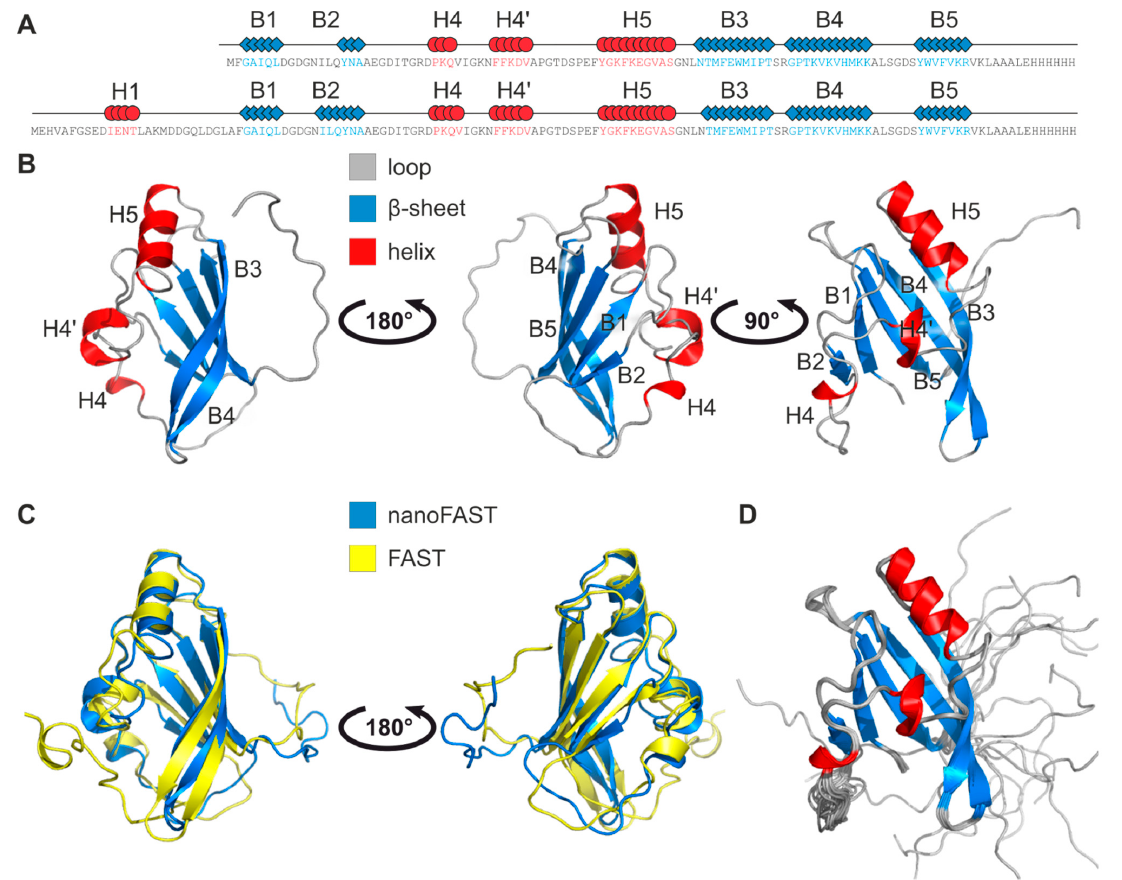
Figure 1. Spatial structure of nanoFAST. ( A )—Secondary structure of nanoFAST apo state, comparison with Fast. α -helixes are shown in red, β -sheets are shown in blue. H1–H5 and B1–B5 stand for the elements of secondary structure, α -helices and β -strands, respectively. Numbering corresponds to the structure of the ligand-bound full-length FAST protein. ( B )—Structure of nanoFAST apo state in ribbon representation. ( C )—Comparison of spatial structures of nanoFAST (blue) and FAST (yellow) in their apo states. ( D )—Twenty best structures of nanoFAST apo state, superimposed over the backbone atoms of the secondary structure elements. α -Helices are colored in red, β -sheets are shown in blue, coil regions are shown in